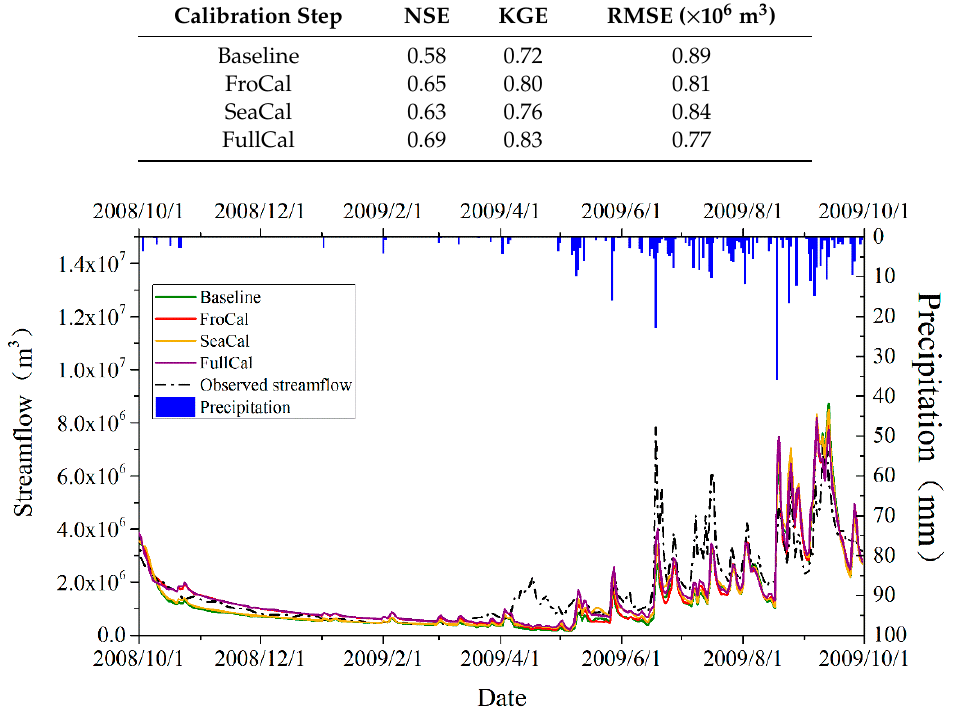
Figure 3. Simulated daily streamflow with the parameters optimized in each of the four calibrated steps during the calibration period of 1 October 2008 to 30 September 2009.